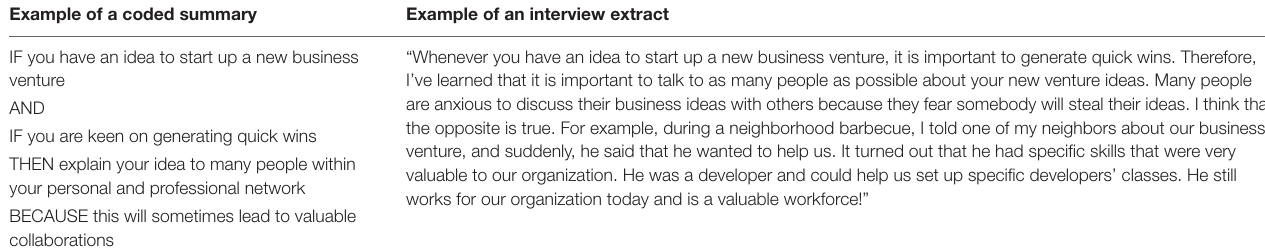
TABLE 2 | Combination of the procedural format and contextual stories. Example of a coded summary Example of an interview